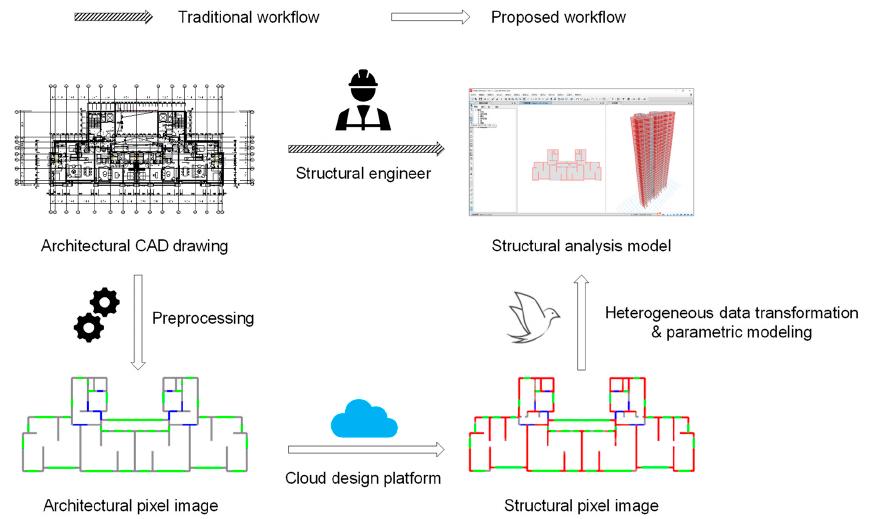
Figure 1. Traditional and proposed workflows of schematic design.